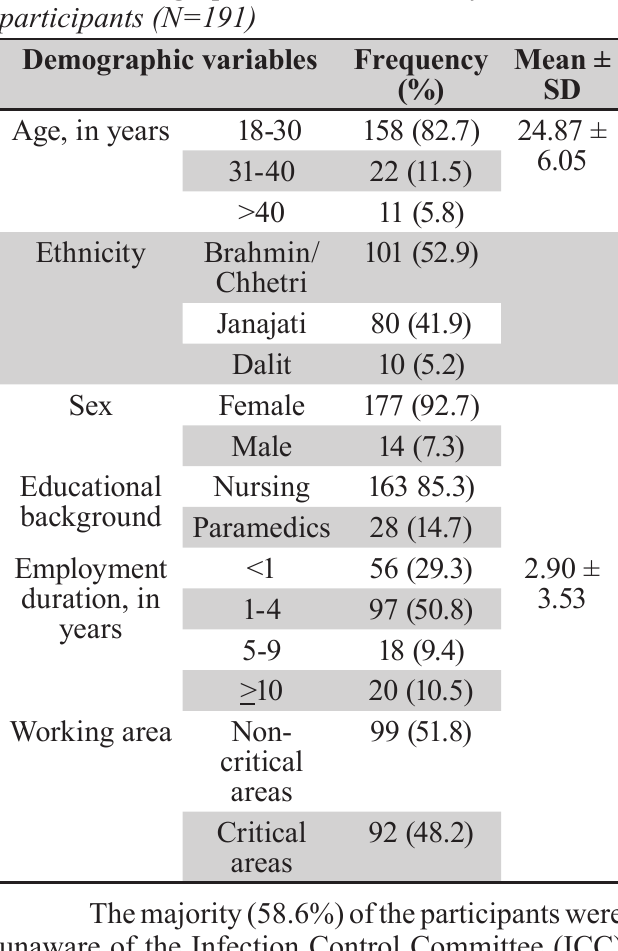
barriers for adherence to standard precautions Table 1. Demographic characteristics of